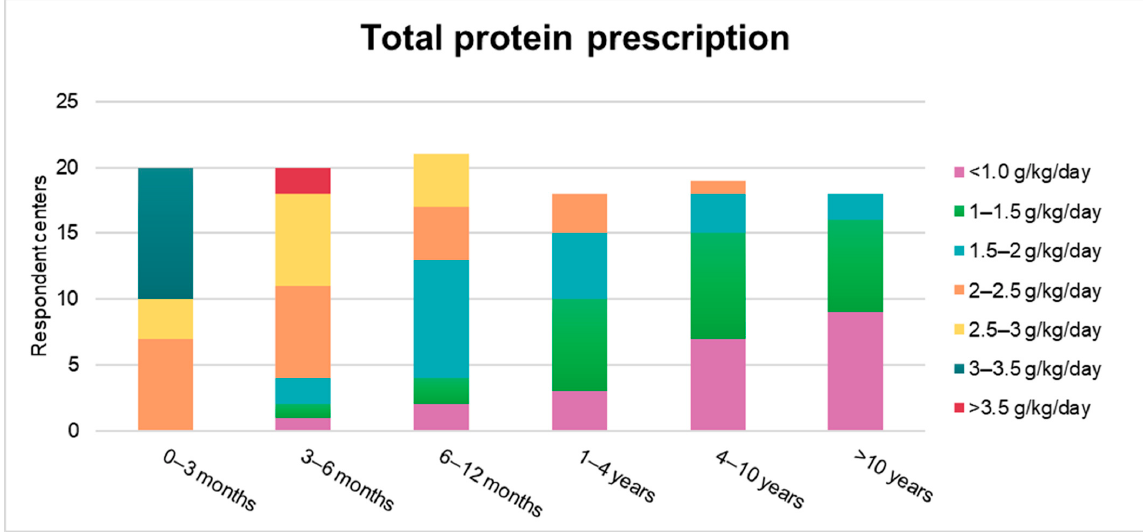
Figure 3. Total protein (natural + protein substitute) prescriptions, in different age groups, in the studied centers ( n = 22) Some centers did not fully answer this question; therefore, the sample size varies in different age groups.